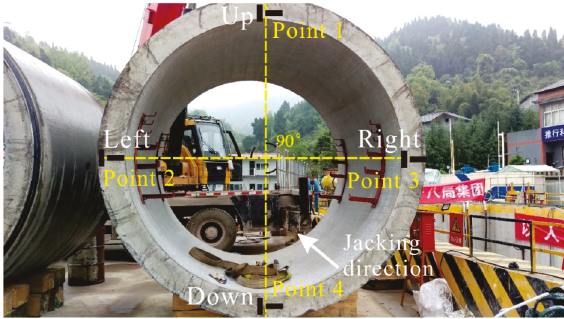
Figure 28: Layout of measurement points.